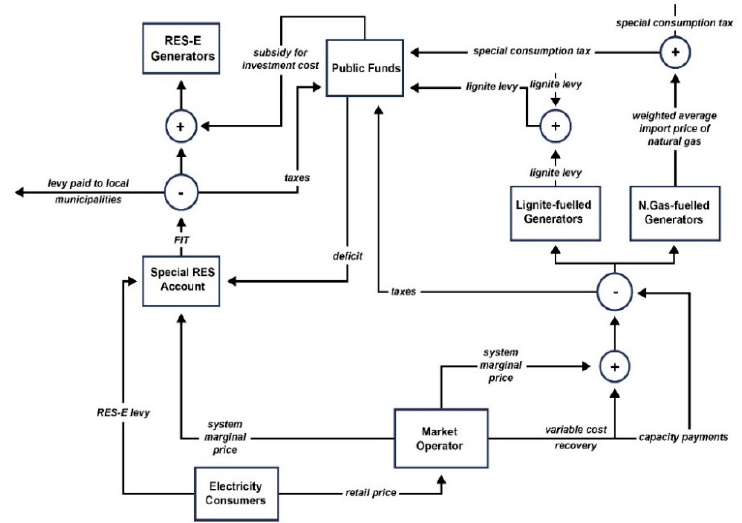
Figure 2. Major monetary flows in the Greek wholesale electricity market from 2009 to 2013.